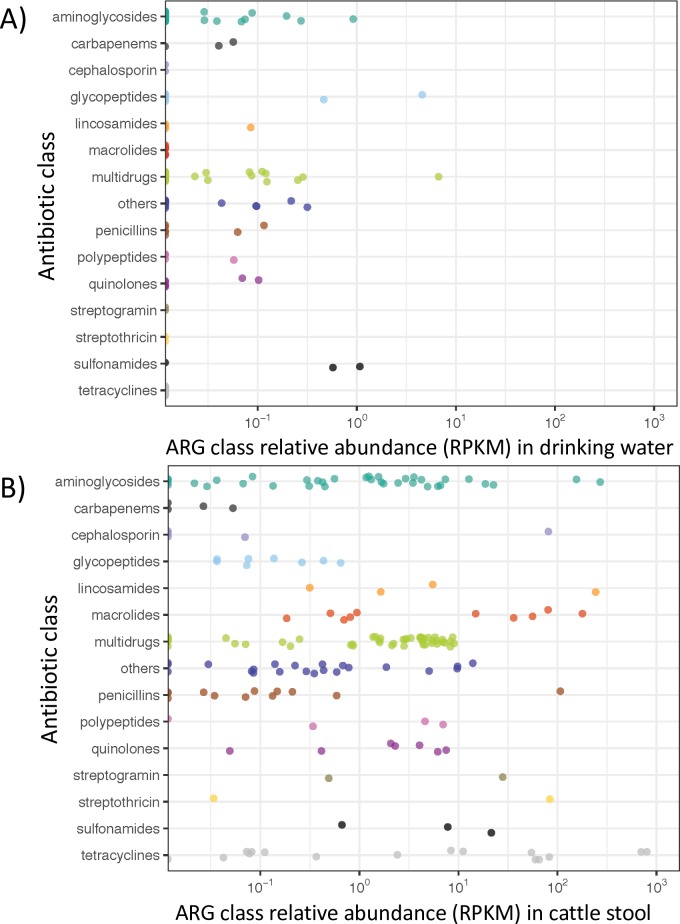
ARG class relative abundances in drinking water and livestock stool metagenomes.ARGs were quantified as for dust in Fig 1 (average per gene across samples) from 25 drinking water and 13 animal stool metagenomes [2, 4]. ARG levels per class in A) drinking water were similar to those in dust, as were overall ARG levels (Fig 4), while B) in livestock most classes and particularly tetracycline, streptothricin, macrolide, and lincosamide resistance were much more abundant.